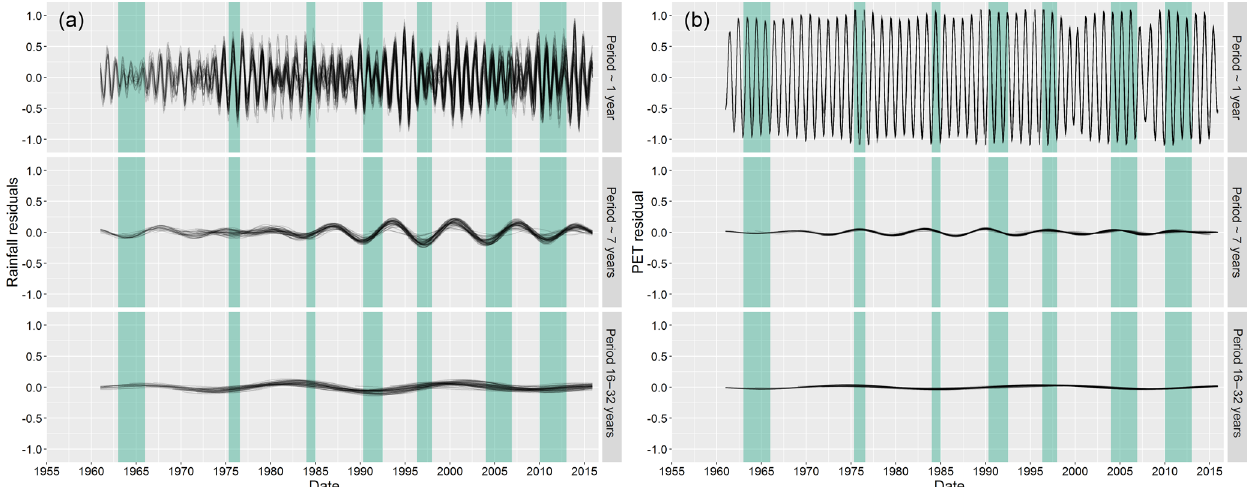
Figure 5. Overlaid rainfall (a) and PET (b) reconstructions of the three key periodic domains are shown. All periods (both significant and non-significant) within these bands have been displayed to allow for comparison of period strength and phase over time. Areas shaded green represent approximate periods of significant droughts in the UK. Only reconstructions between 1955 and 2017 are shown to allow clearer